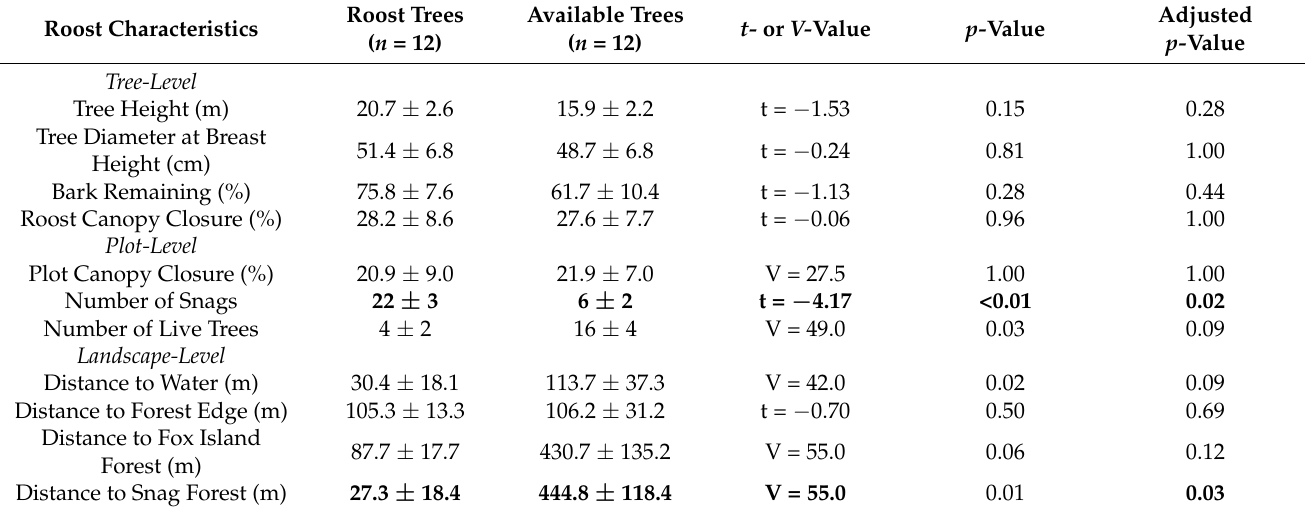
Table 1. Comparison of roost and available tree characteristics for a population of northern long-eared bats ( Myotis septentrionalis ) in Fort Wayne, Indiana, studied from 2019–2021. Bold text designates statistical significance. Data are reported as mean ±